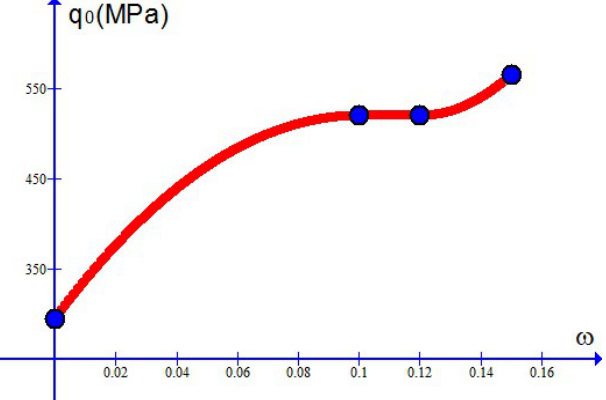
Figure 12. The maximum stress limit q 0 changing with the weight percentage ω (dots for simulation